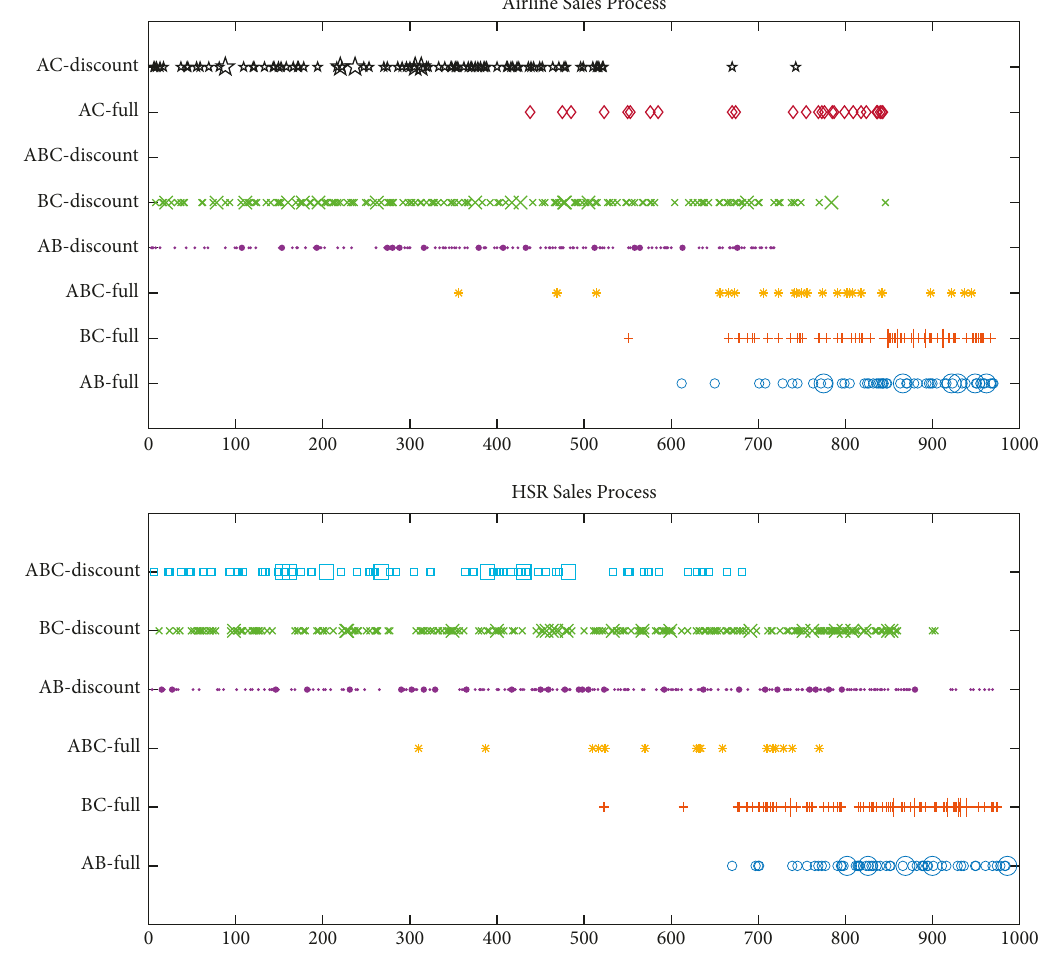
Figure 10: The sales process of airline and HSR. Table 7: Revenue comparison.